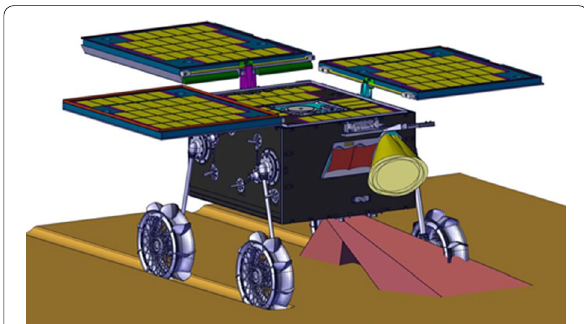
Fig. 2 MMX rover with deployed wheels and solar panels in the on-surface configuration. Field of views of miniRAD and Wheelcams are indicated in yellow and red, respectively. Courtesy from